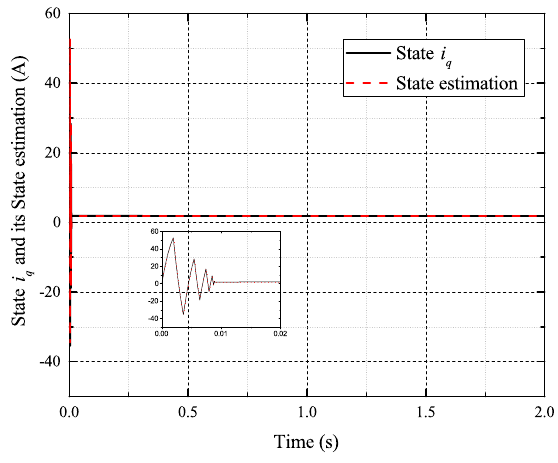
Figure 18. State i q and its estimated value ˆ i q .